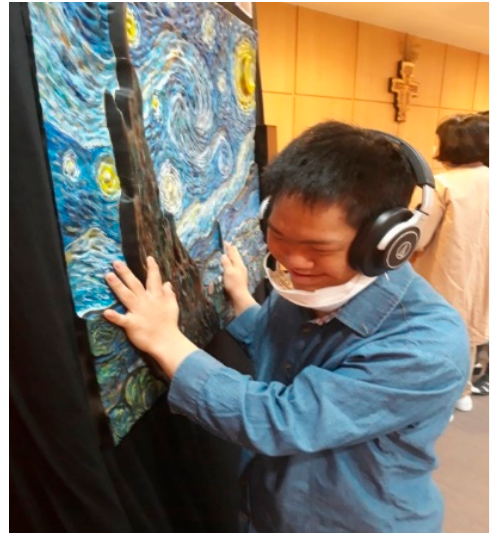
Figure 2. A student viewing the "Starry Night" by Vincent van Gogh reproduced in 2.5D at the BlindTouch exhibition (Cheongju St. Mary's School) [36].